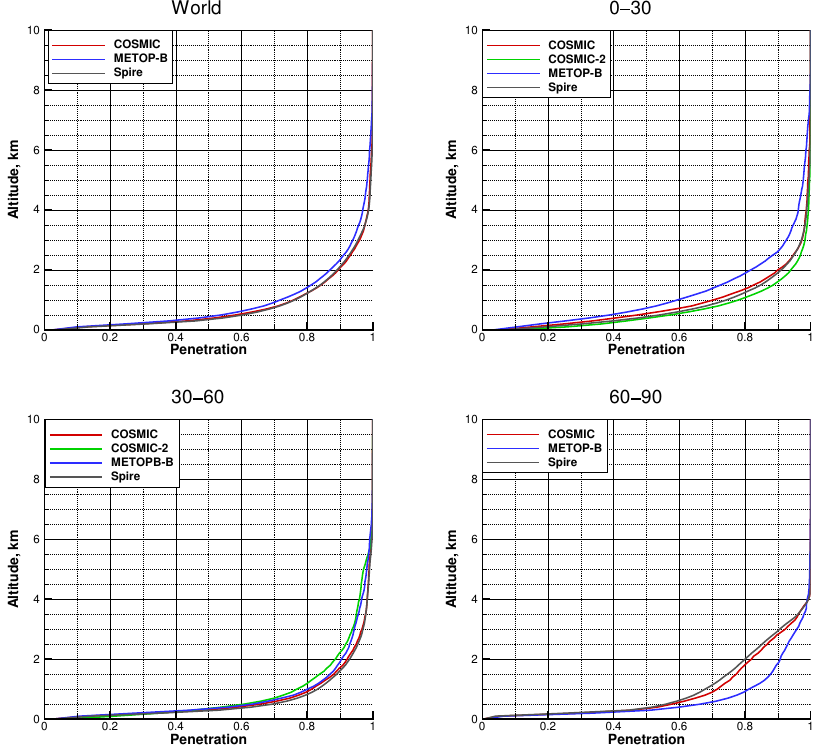
Figure 19. Similar to Figure 17. Penetration, dynamic